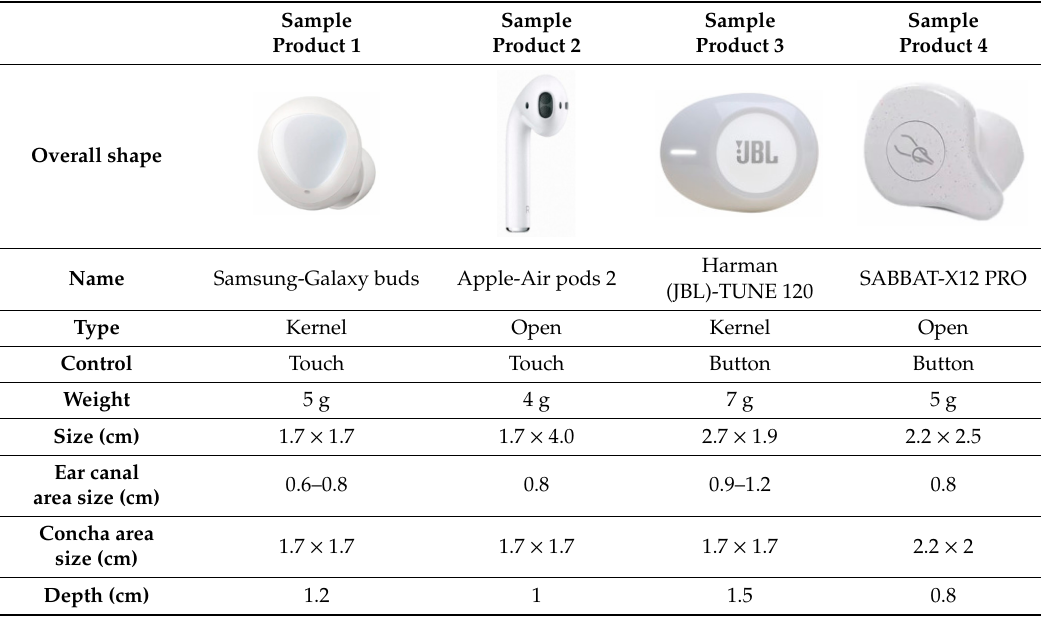
Table 1. Specifications of sample